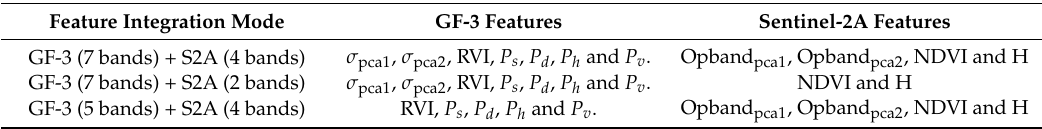
Table 5. Details on different feature integration modes.